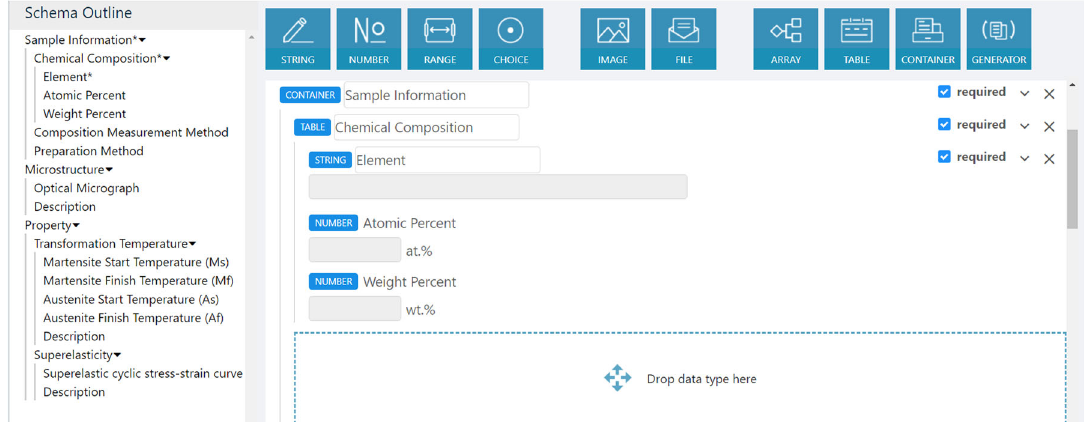
Fig. 2 The graphical user interface of the container schema designer. The designer allows users drag icons of data types and drop them to the dotted box to construct their schemas. The schema structure of the example data of shape memory alloys is shown in the Schema